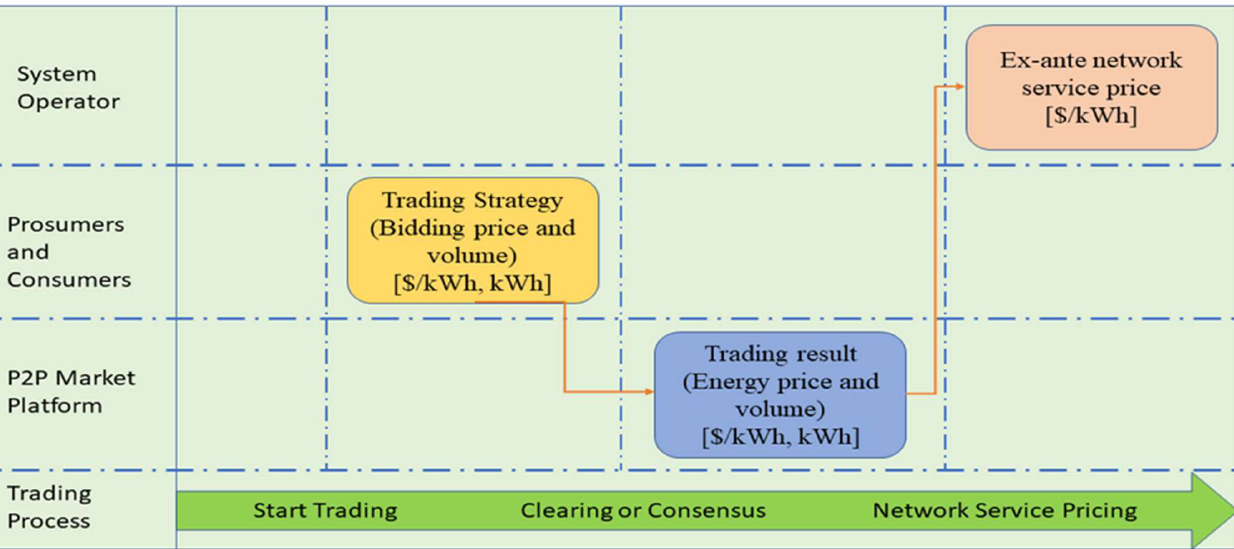
Figure 9. P2P energy trading process based on the ex-post network service pricing .